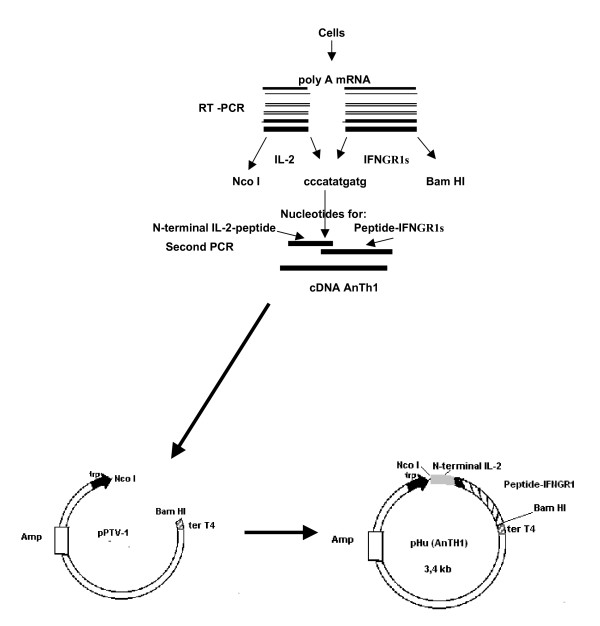
Construction of the expression plasmid pHu (AnTH1). The figure illustrates the process started from Poly-A mRNA purification from cell lines, followed by the RT-PCR of respective cDNA fragments. The amplified cDNA TH1 antagonist (AnTh1) contains in its extremes the sequences for NcoI and BamHI restriction enzymes suited for cloning in the pPTV-1 vector (left at the bottom of diagram). In the center is indicated the nucleotide sequence (ccatatgatg) coding for the linking peptide. The final genetic construction is shown at the bottom right.